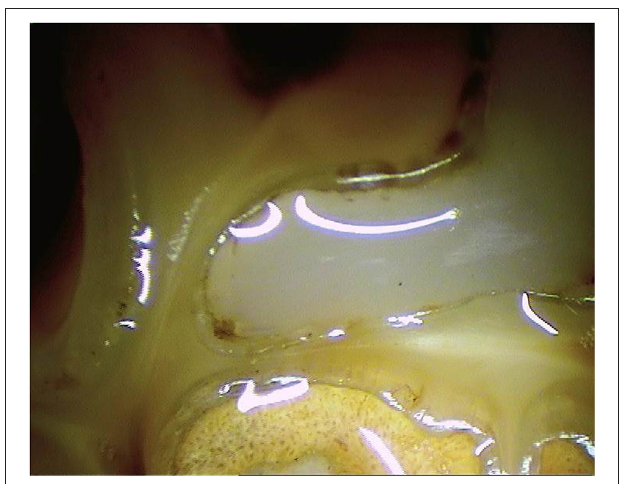
FIGURE 8 | Oroscopic image of the distal buccal infolding of the mesial infundibulum of a Triadan 109 tooth 15 months post-restoration.